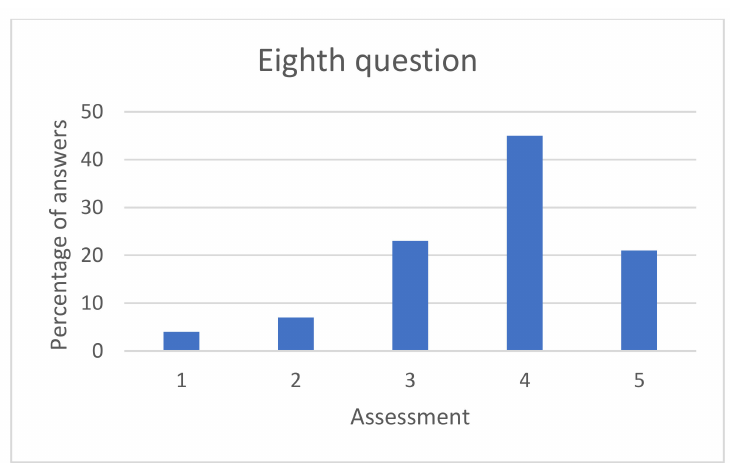
Figure A9. Results of question